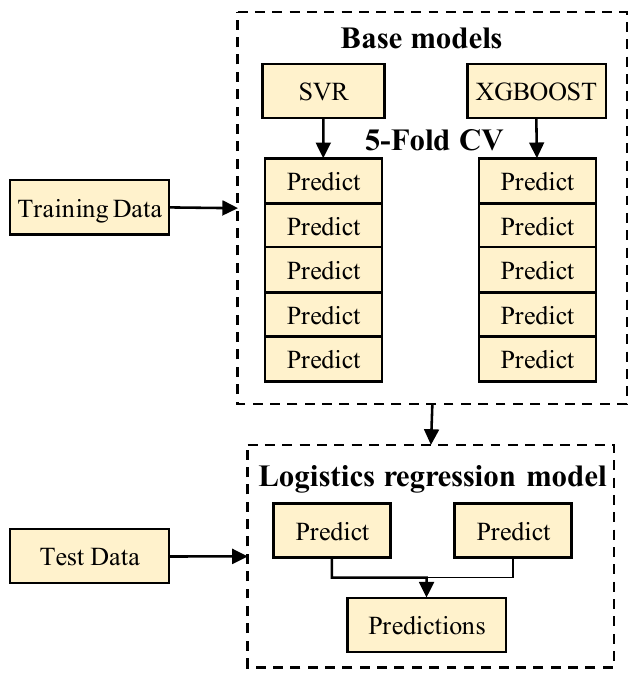
Figure 9. Stacking-based integrated learning prediction model.